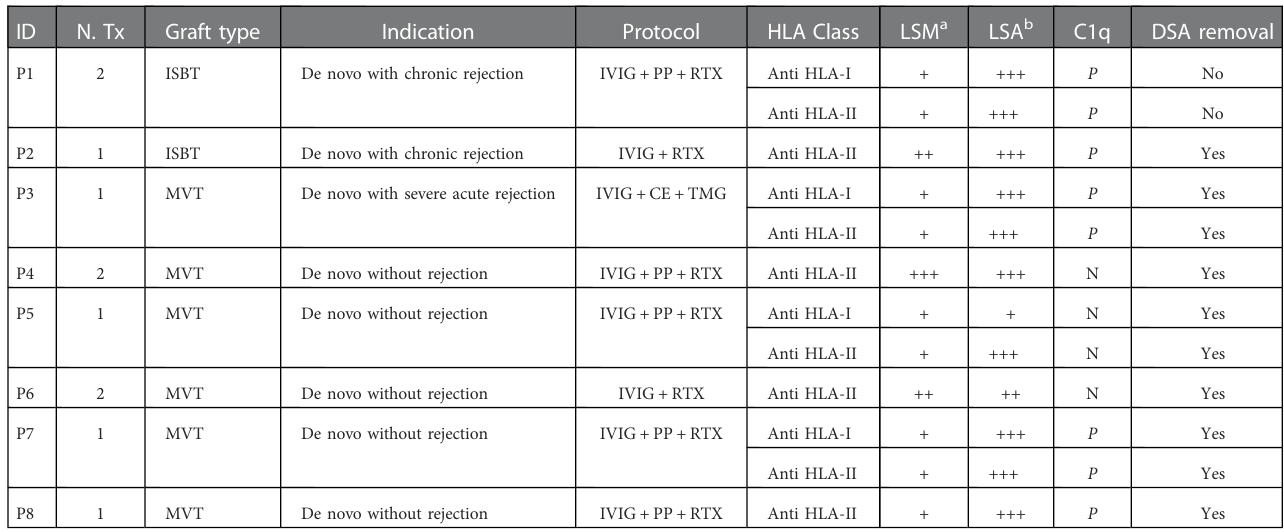
TABLE 2 Summary of the ART carried